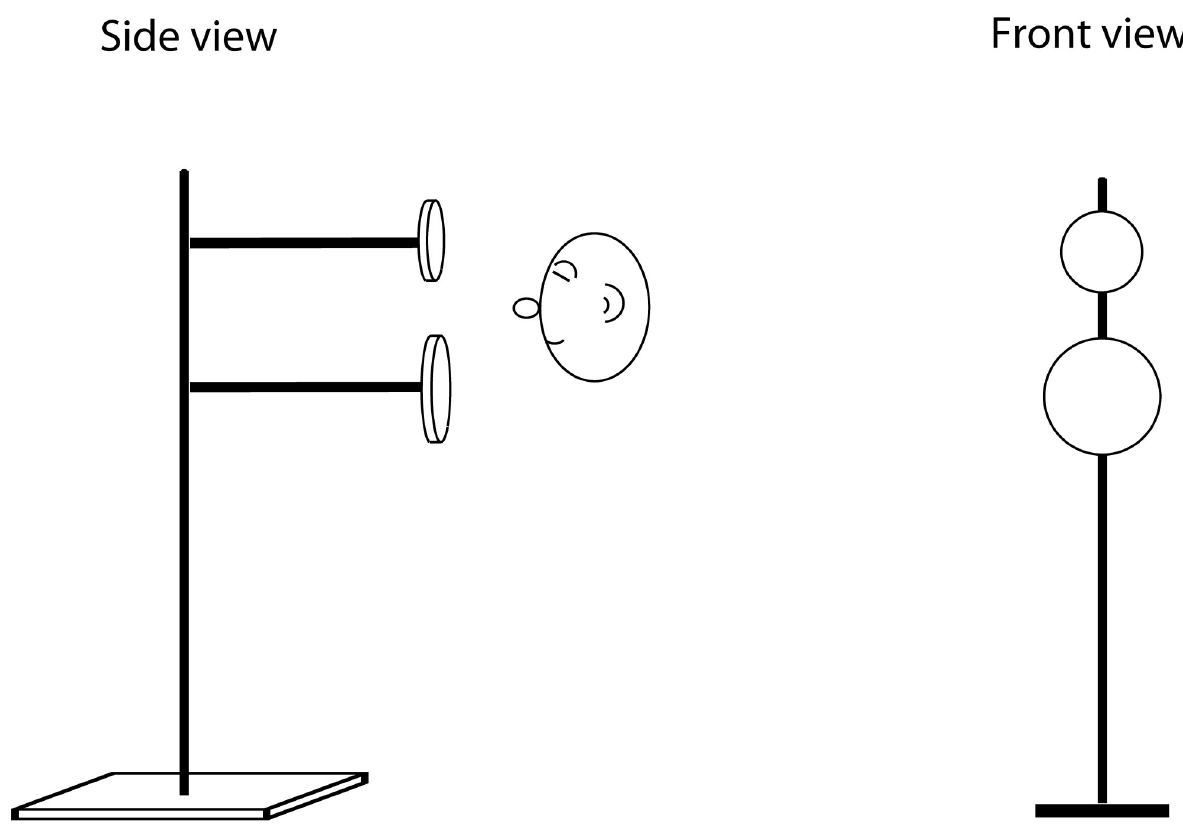
Fig 2. Illustration of the apparatus used for the size discrimination task. The (larger) reference disk was used in every trial, and placed either on the top or the bottom bar (here: on the bottom). One of the five (smaller) comparison disks was placed on the remaining, free bar. 2.3.2. Training tasks. 2 . 2 . 2 . 1 . Size Discrimination Task and Control Task (no click) . This task was introduced by [19] and has been shown to be sensitive to differences in blind peoples’ ability to use click-based echolocation based on long-term experience, and to be sensitive to improvement in performance through training in people who are sighted, e.g. [18,19]. Apparatus : The apparatus consisted of a vertical round metal pole (1 cm circular diameter), from which two horizontal round metal poles (1 cm diameter) protruded 50 cm towards the participant. The horizontal crossbars were used to mount circular discs made from 0.3 cm foam board. The discs were mounted with a small pin on their back. The largest disc (the refer- ence disc) was 25.4 cm in diameter. The five comparison discs had diameters of 5.1 cm, 9 cm, 13.5 cm, 17.5 cm and 22.9 cm. Fig 2 illustrates the setup. Task and Procedure : Participants’ task was to determine if the larger (reference) disk had been located on the top or bottom bar and to signal their response with a silent hand signal. Participants stood in front of the apparatus facing the discs and were encouraged to move their head, with the restriction that they should remain at the same distance (i.e. only up, down, left, right movement was allowed). The height of the apparatus was adjusted so that their ear was equidistant to the top and bottom horizontal bar of the apparatus. The experi- menter monitored the participant’s distance from the apparatus at all times. There were 30 tri- als in total, during which each comparison disk was used 6 times (three times on the top and three times on the bottom bar) in random order. Each trial followed the same sequence. First, participants blocked their ears with their index fingers whilst the experimenter positioned the